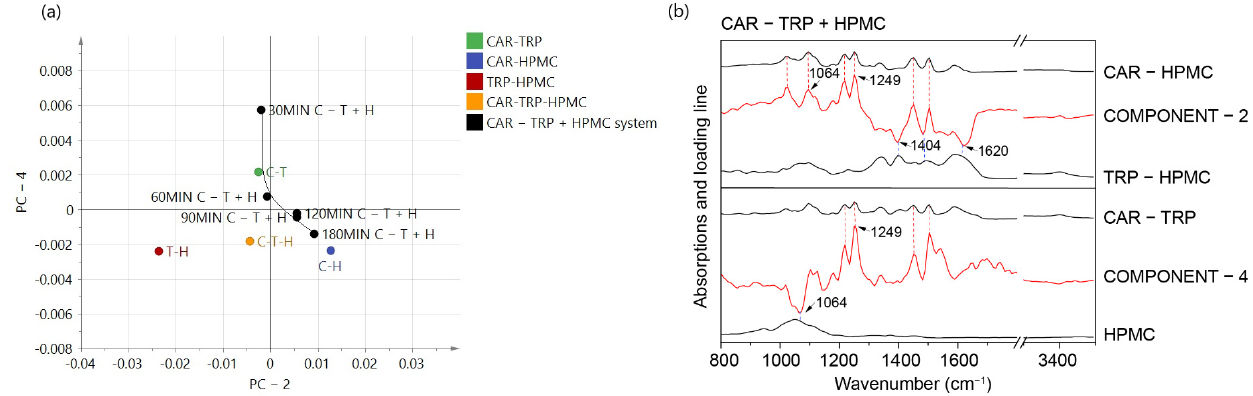
Figure 3. PCA score plot of FTIR spectra of CAR − TRP + HPMC, PC-2 was plotted against PC-4 ( a ). Loading plot of PC-2 and PC-4. Reference FTIR spectra of CAR-HPMC, TRP-HPMC, CAR-TRP binary amorphous systems and HPMC ( b ).